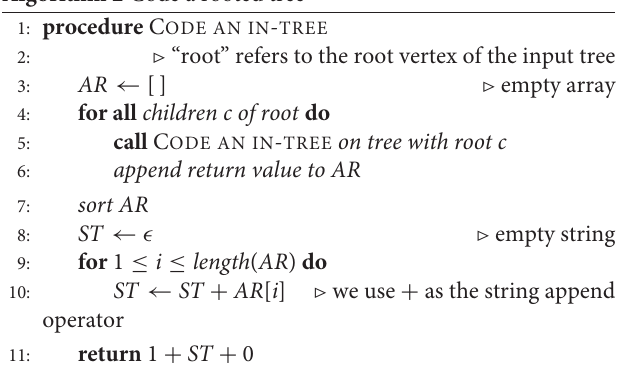
Algorithm 2 Code a rooted tree